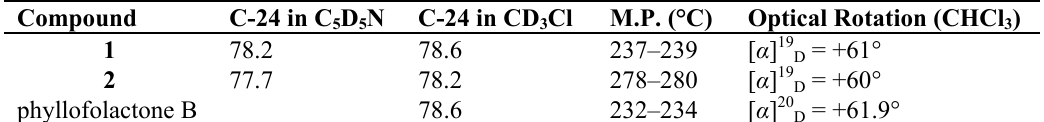
Table 2. Comparison of 13 C-NMR and Physical Data for Compounds 1 , 2 , and reported phyllofolactone